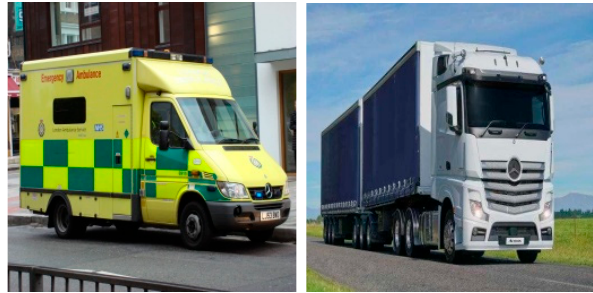
Figure 5. Sample images of an emergency vehicle and a truck. Table 6. Vehicle type classification test set results.